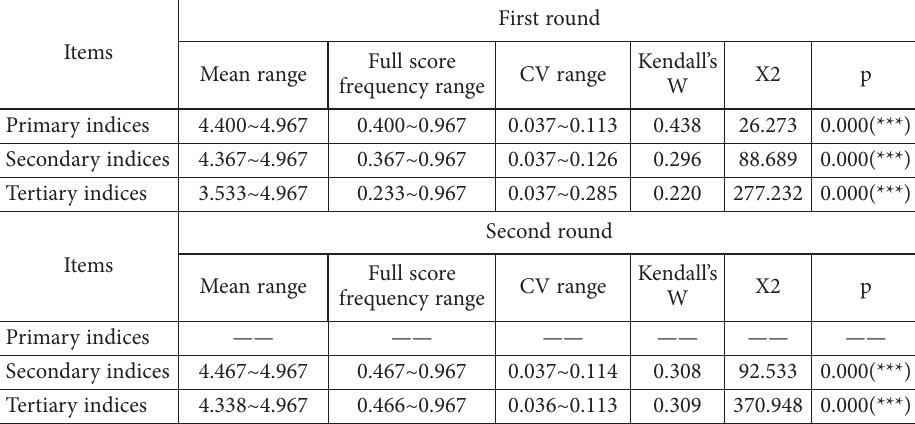
Table 7. Data analysis table of coordination and concentration (consistency) of expert